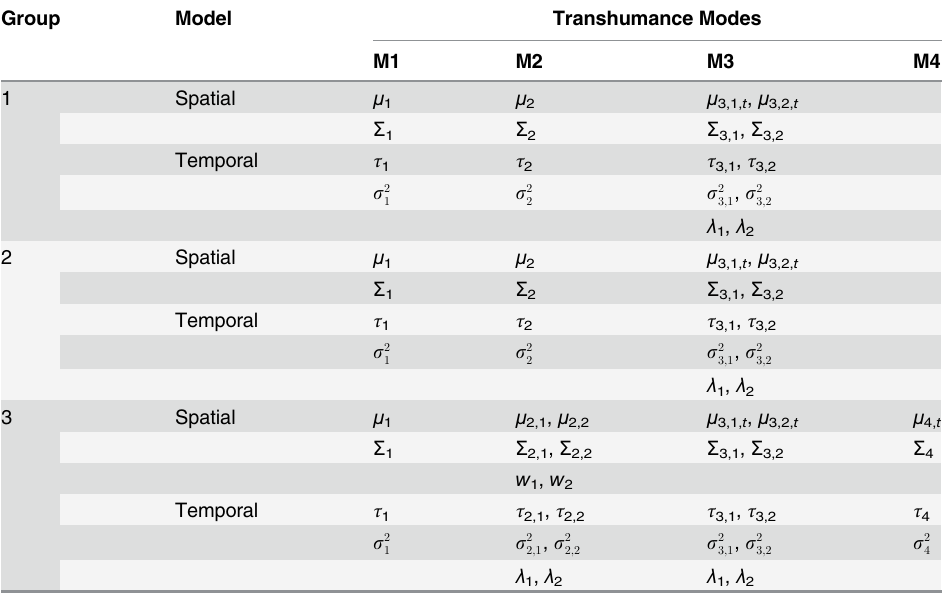
Table 2. Parameters for the spatial and temporal mobility (STM)